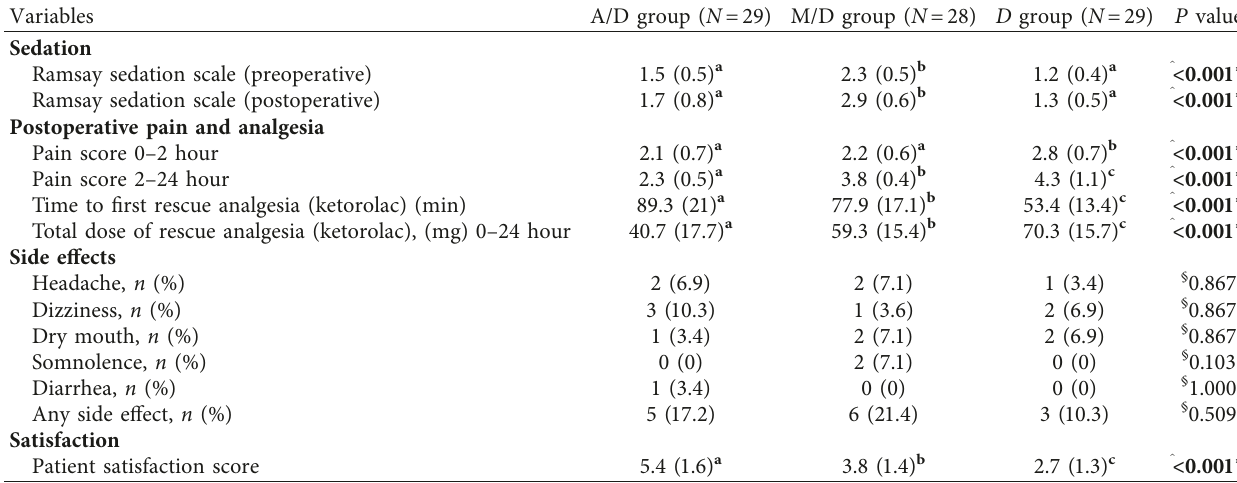
Table 3: Postoperative findings among the studied